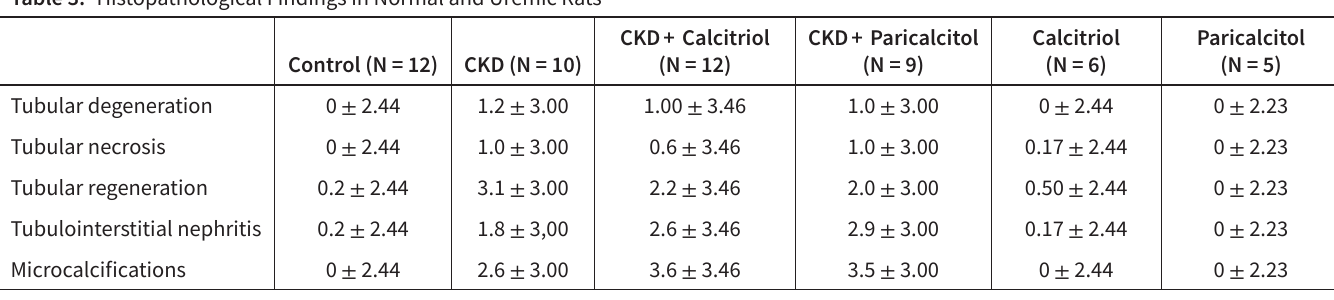
Table 3. Histopathological Findings in Normal and Uremic Rats